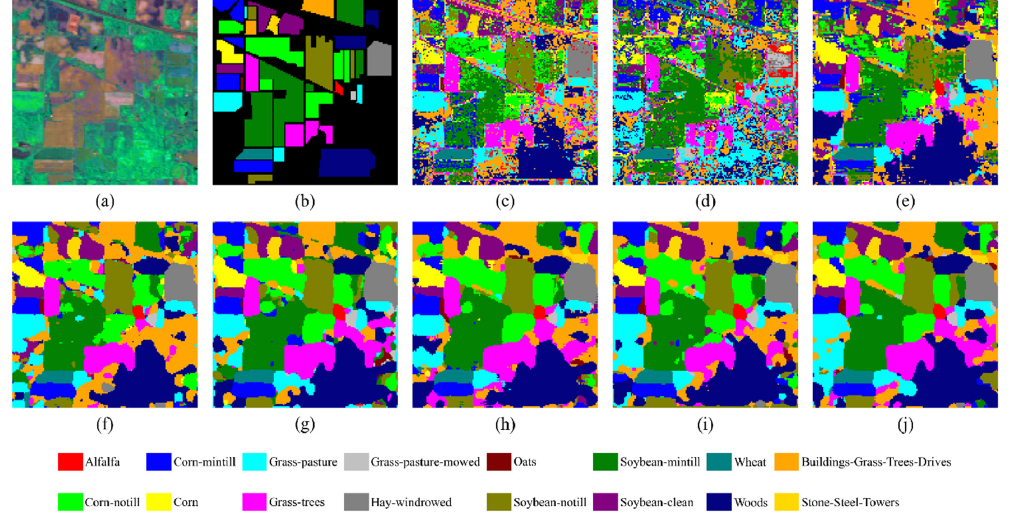
Figure 4. Classification maps of the different models for IP data set: ( a ) False-color image. ( b ) Ground-truth. ( c ) SVM ( d ) MLP ( e ) pResNet. ( f ) SCFR-CNN. ( g ) SSRN. ( h ) SSDC. ( i ) FDSSC. ( j ) DPSCN.